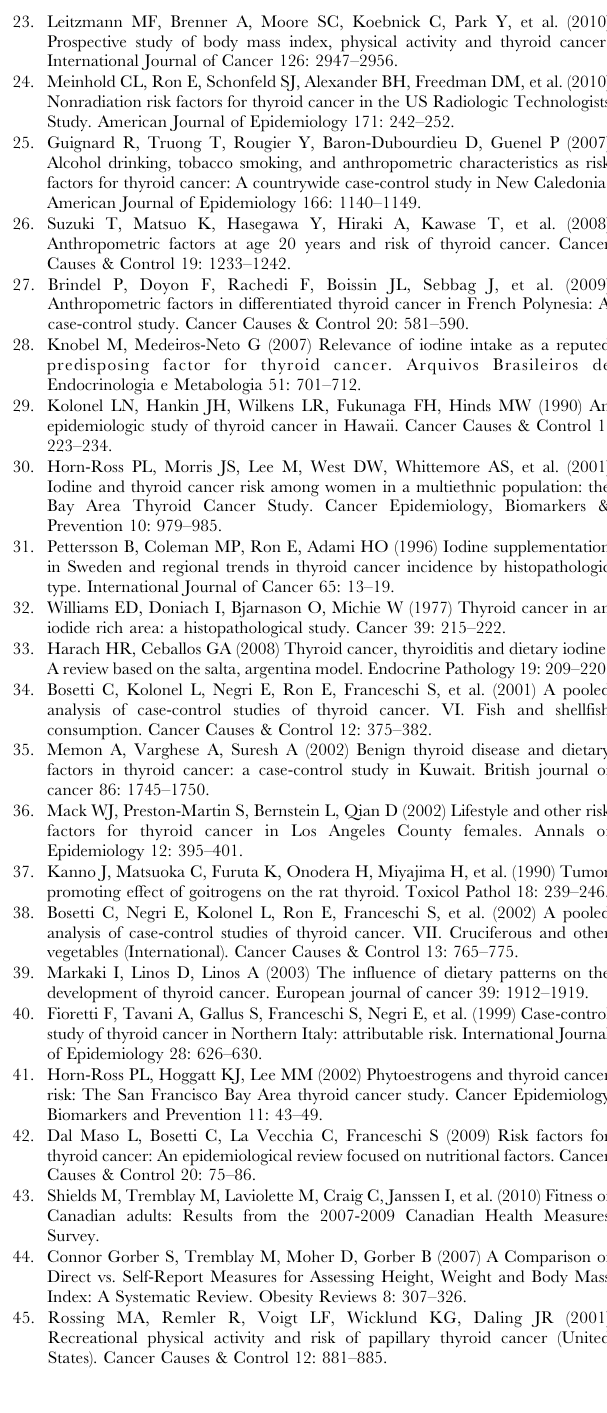
and risk factor definitions across studies. Notable differences in study characteristics and study samples are indicated on the plot. Table S1 Summary of reviewed studies on BMI (body mass index) and thyroid cancer. Table S2 Summary of reviewed studies on diet and thyroid cancer.